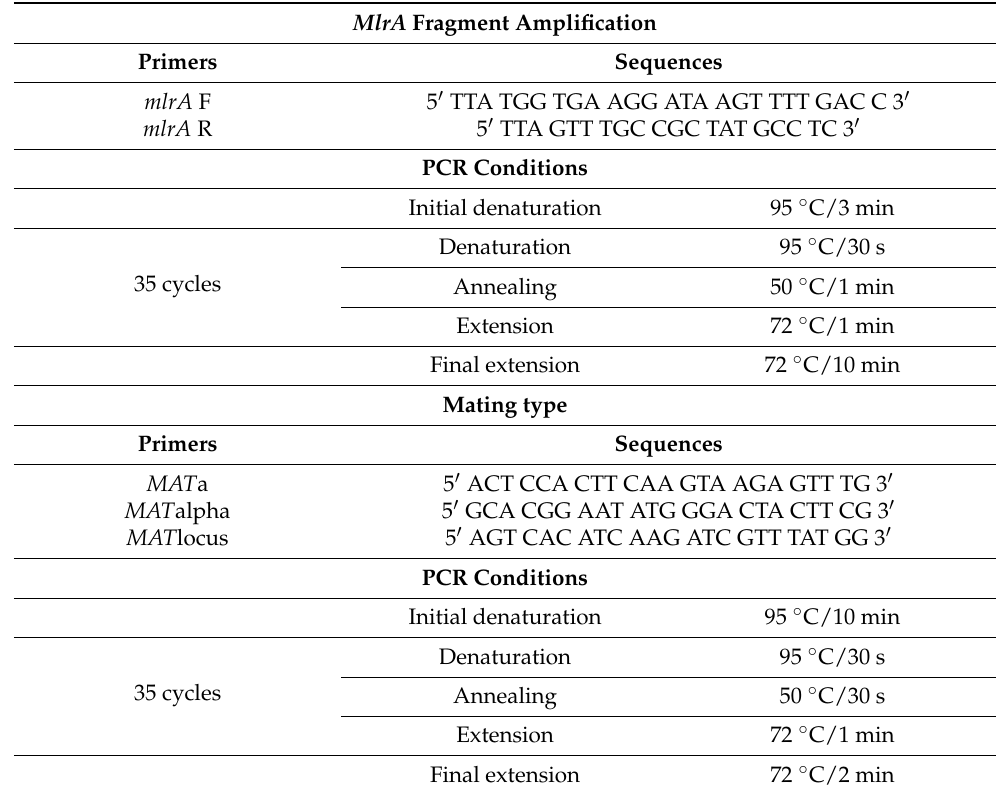
Table 1. Primers sequences and PCR conditions to assess mlrA gene on integrated yeast strains and mating type